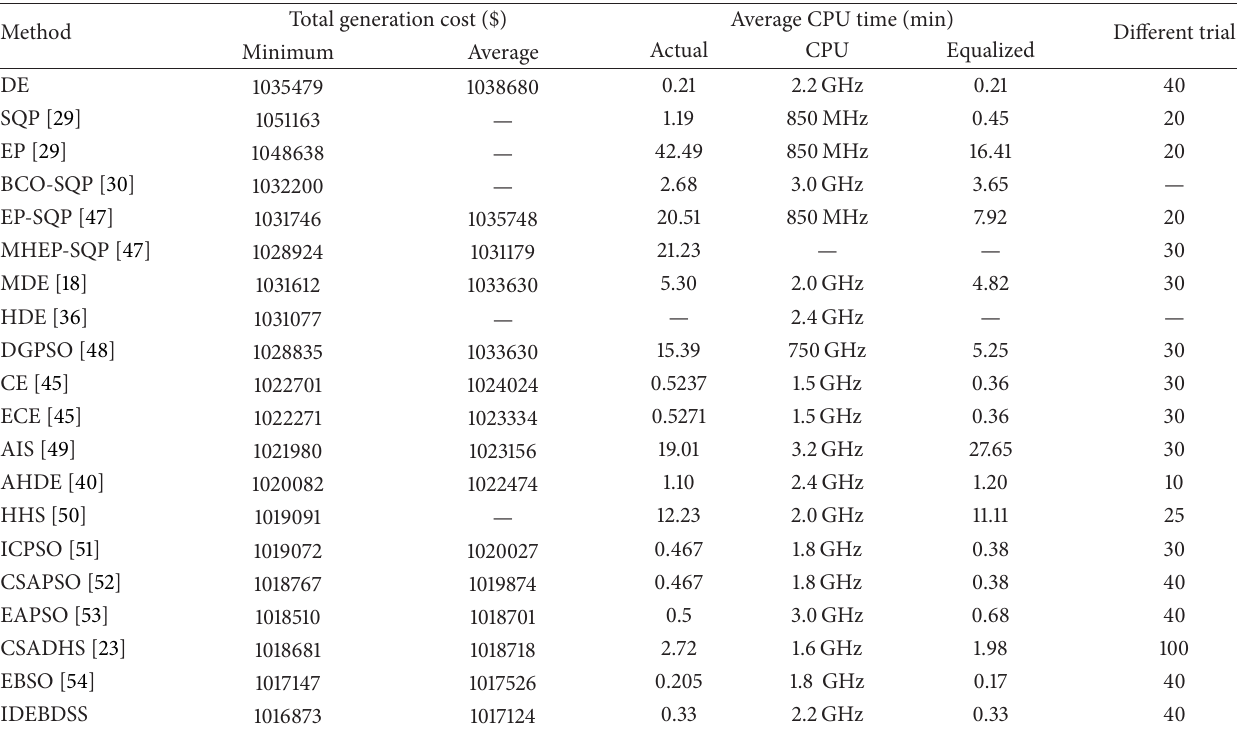
Table 2: Comparison of results with different methods for test system 1.